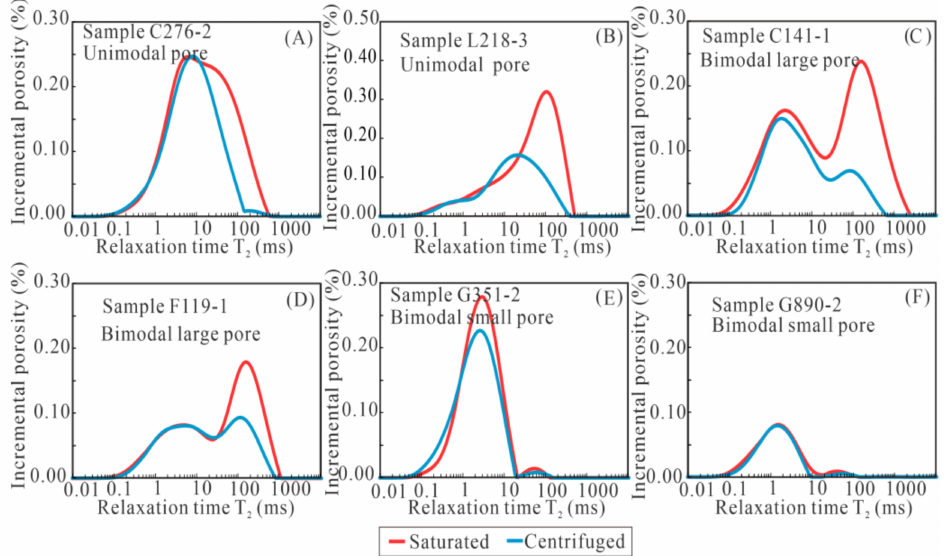
Figure 8. Typical NMR T 2 spectral distributions ( A , B ) showing unimodal behaviors in samples C276-2 and L218-3; ( C , D ) showing bimodal large pores in samples C141-1 and F119-1; ( E , F ) showing bimodal small pores in samples G351-2 and